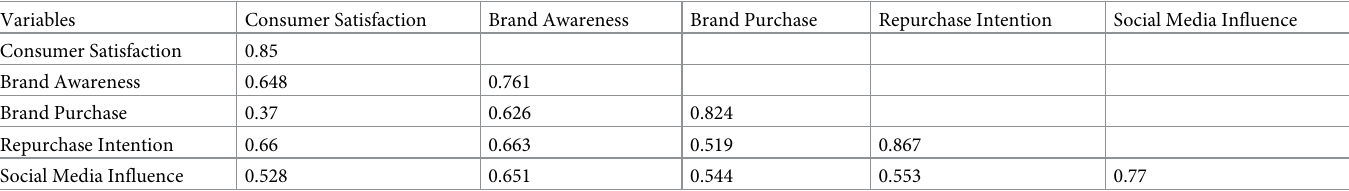
Table 3. Correlation